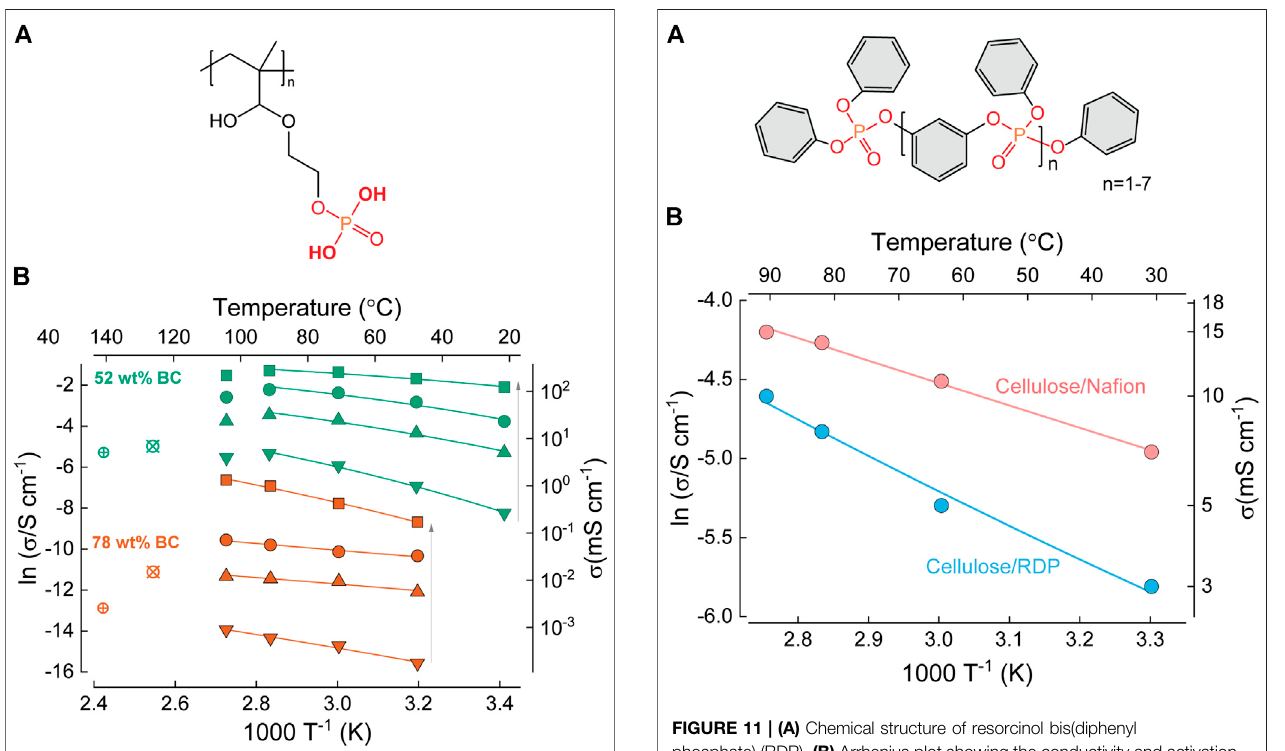
FIGURE 10 | (A) Chemical structure of poly(methacryloyloxyethyl) phosphate (PMOEP). (B) Arrhenius plot of the in-plane conductivity of BC/ PMOEP PEMs containing 52 wt% BC (green data points) or 78 wt% BC (orange data points) at increasing relative humidity of 30, 60, 80 and 98 % (indicated by arrows). Å and Ä symbols correspond to the operating conditions 140 ° C/20% RH, and 120 ° C/ 50% RH, respectively. Redrawn from Vilela et al.